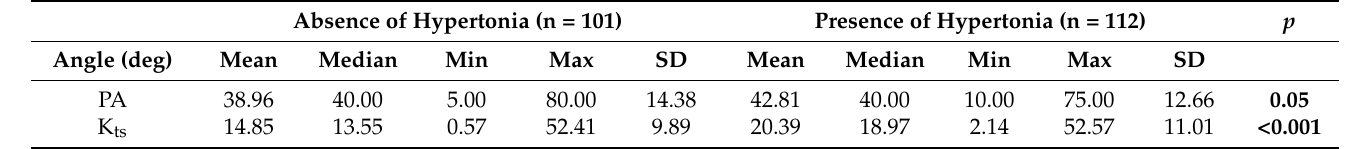
Table 2. The popliteal angle values (PA) and knee angular position at the end of swing/initial stance (K ts ) were larger in the limbs with clinically detected knee flexors hypertonia, when hypertonia had been identified using TAS at fast velocities (HYP vf ).